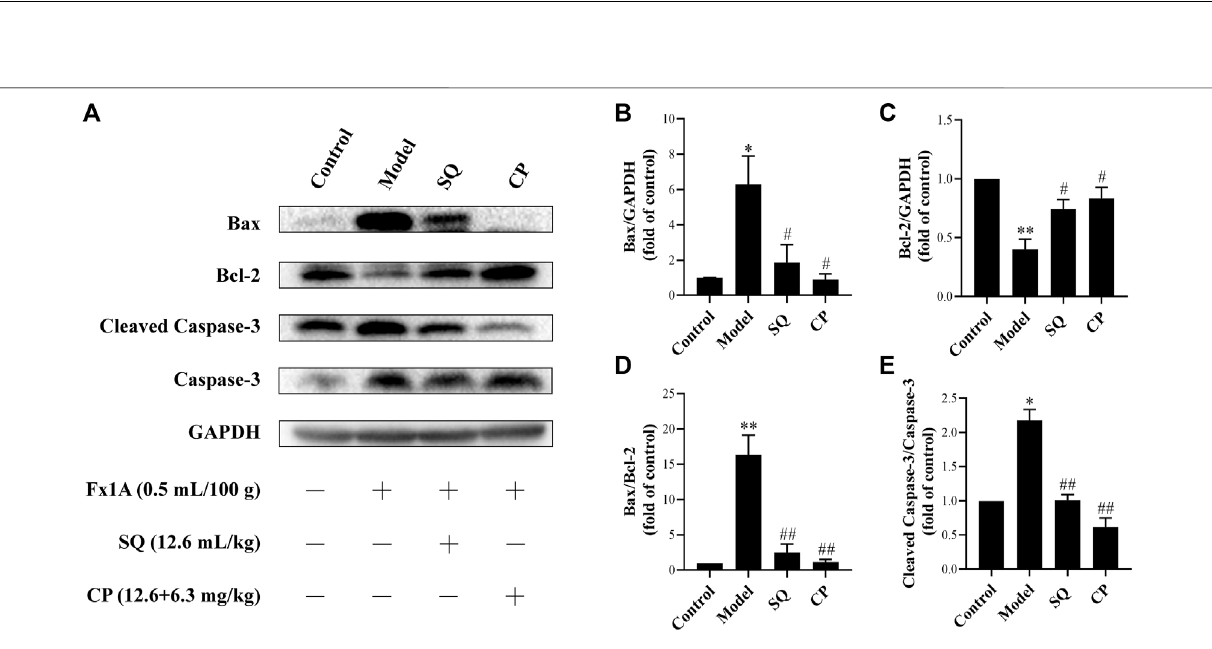
Frontiers in Pharmacology |